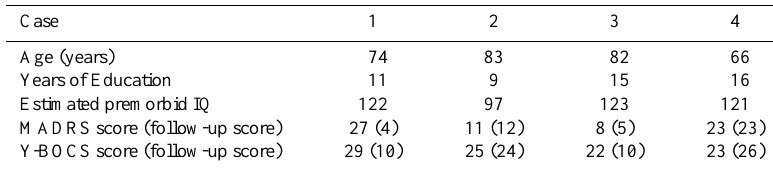
Table 1 Demographic and clinical data at baseline assessment and one year follow-up